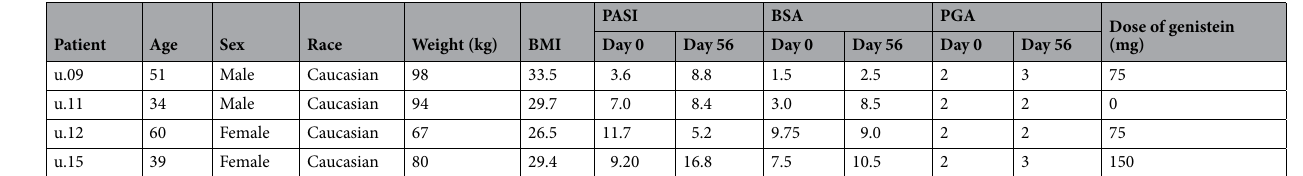
Table 2. Characteristics of psoriasis patients u.09, 11, 12, and 15 in the present study.